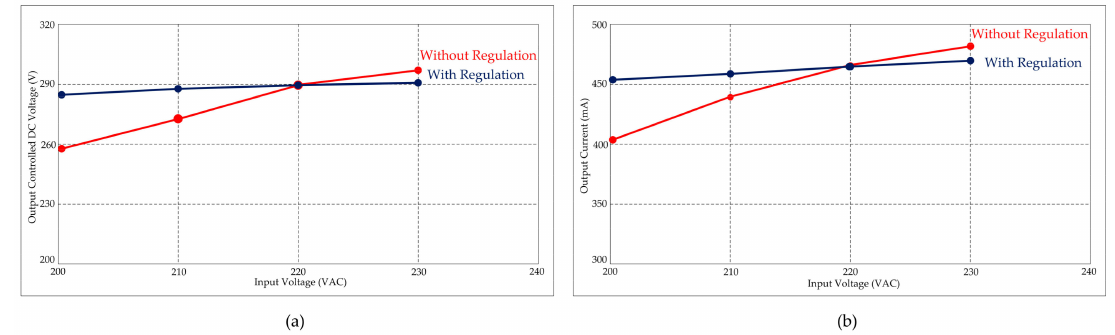
Figure 10. HVHF plasma switching power supply characteristic waveforms with and without regulation. ( a ) Input voltage vs. output DC controllable voltage; ( b ) input voltage vs. output current.